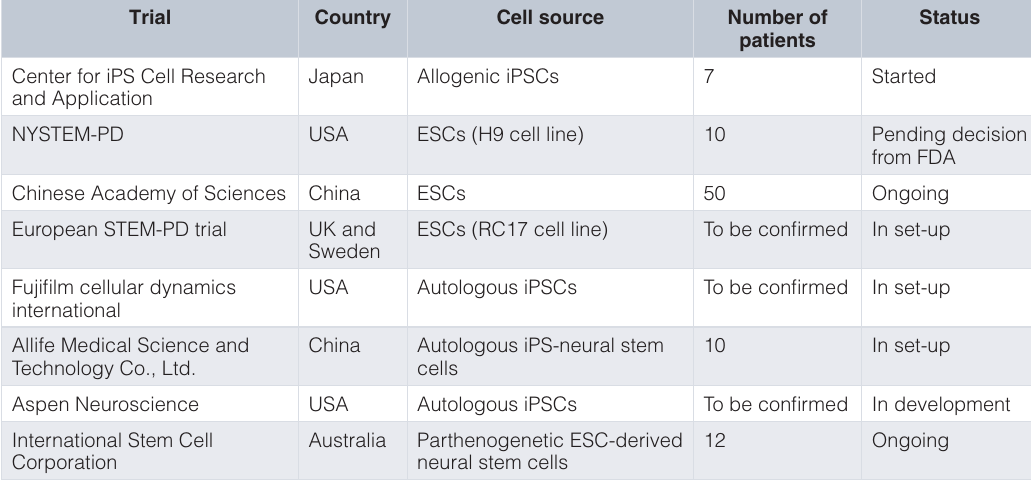
Table 2. Current and planned trials of human stem cell-derived neuronal